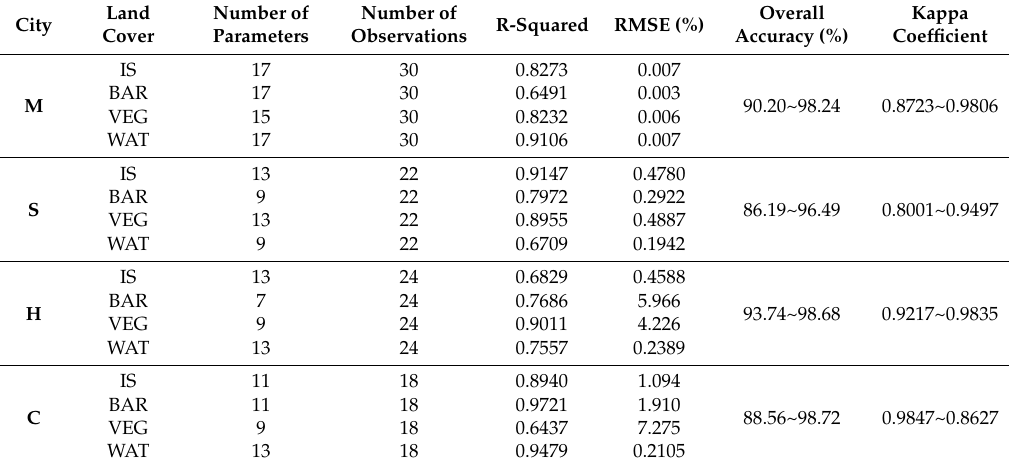
Table 3. Factors of uncertainty in the Fourier series